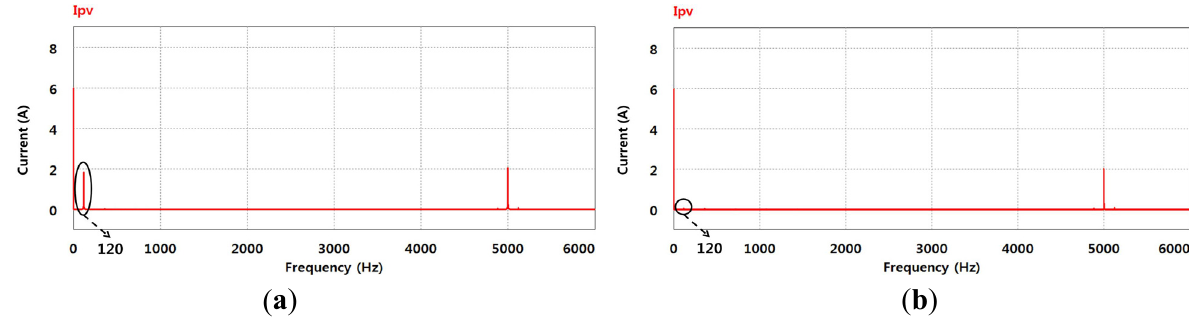
Figure 17. Simulation FFT waveform of PV current. ( a ) Without compensation; ( b ) with compensation.